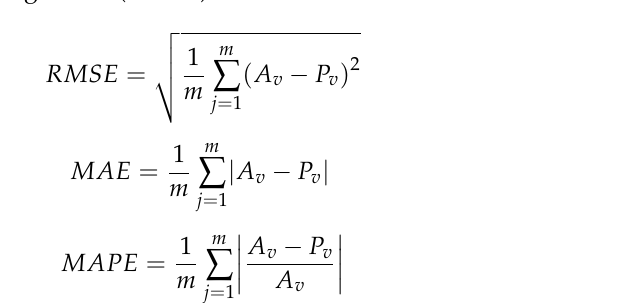
Figure 7. Current measured at the load for battery B0005 at different cycles.